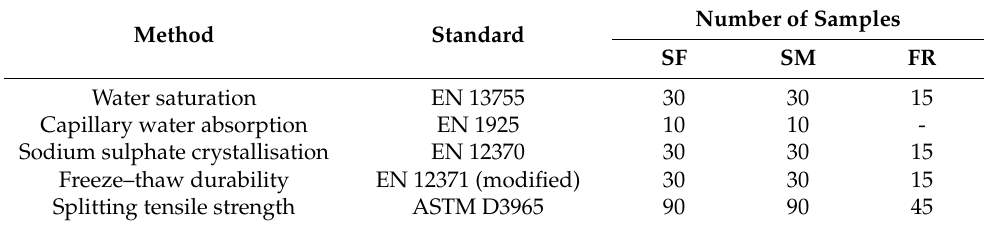
Table 2. Experimental methods and number of samples.